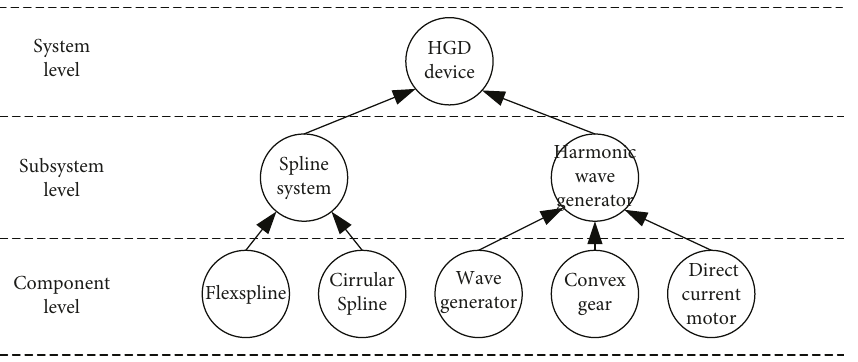
Figure 3: Structure representation of the HGD